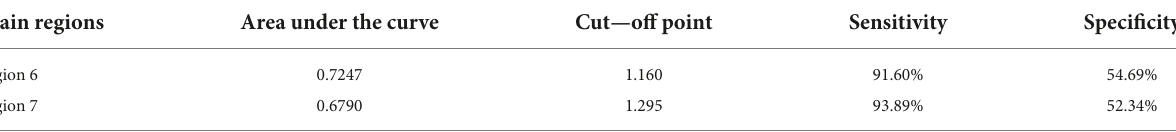
TABLE 3 ROC analysis for differentiating SCH patients from HCs by using ALFF values in region 6 and 7. Brain regions Area under the curve Cut—off point Sensitivity Specificity Region